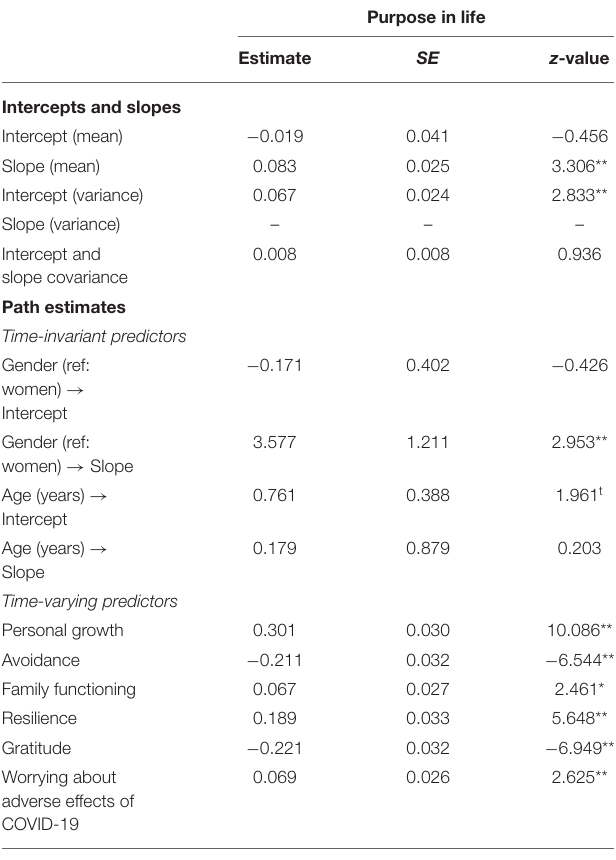
TABLE 2 | Results from latent growth curve model with predictors for purpose in life.